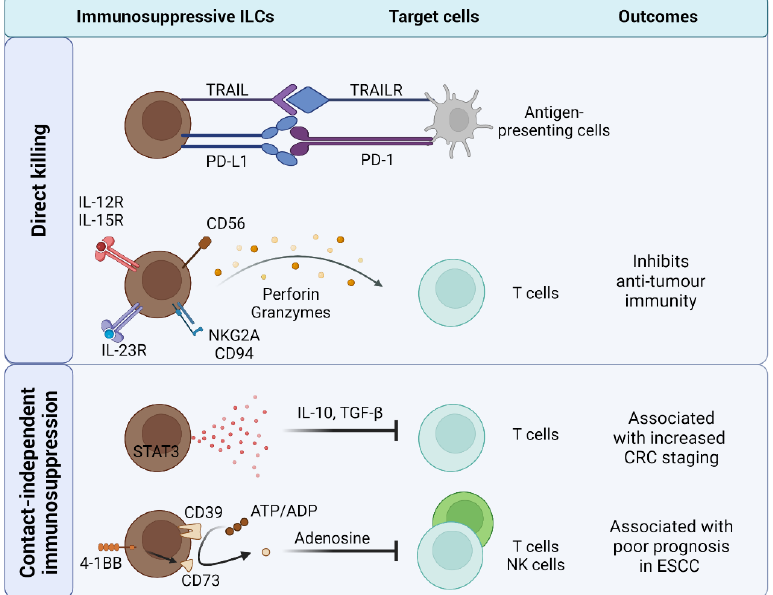
Figure 3. ILCs suppress anti-tumour immunity through contact-dependent and contact-independ- ent mechanisms. ILCs play active roles in suppressing T-cell-mediated clearance of tumours through direct-killing of T cells using perforin and granzymes, production of immunoregulatory molecules (e.g., IL-10 and TGF- β), and conversion of ATP into suppressive adenosine through ectoenzymes (e.g., CD39, CD73). Furthermore, ILCs directly kill antigen-presenting cells (APCs) preventing them from cross-priming CD8 + T cells in the lymph nodes.